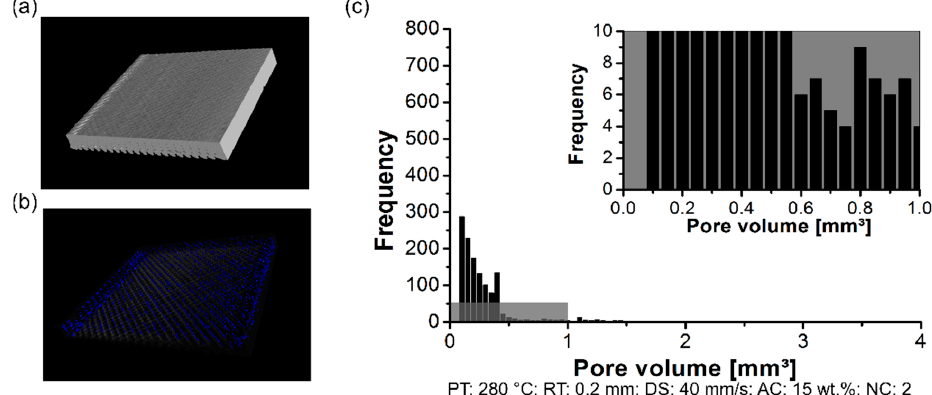
Figure 8. Pore distribution on the 3D ‐ printed ABS for condition one (PT: 280 °C, RT: 0.2 mm, DS: 40 mm/s, AC: 15 wt.%, and NC: 2): ( a ) scanned volume, ( b ) pores distribution, and ( c ) pore volume histogram.